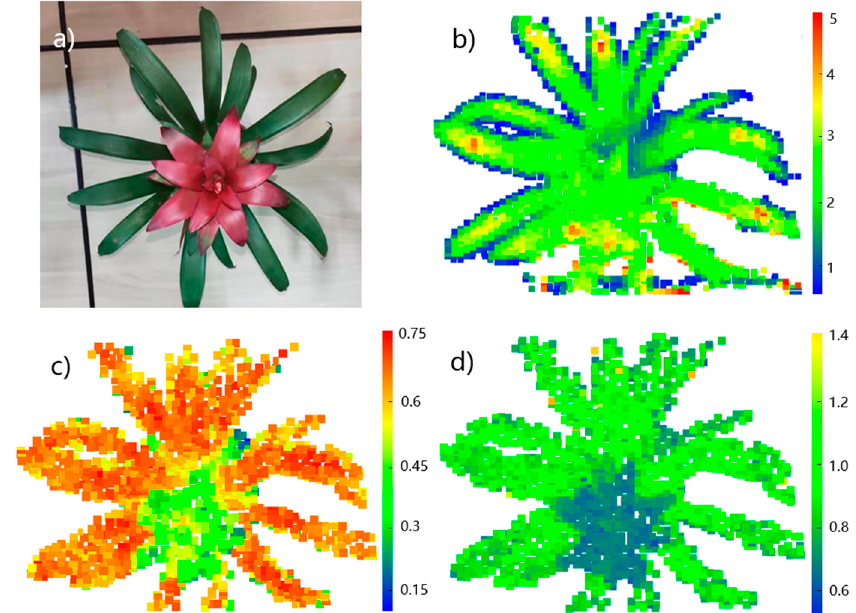
Figure 14. Hyperspectral LiDAR backscatter intensity correction visualization. ( a ) Kniphofia ; ( b ) before correction (near ‐ infrared wavelength intensity ‐ 784 nm); ( c ) after correction (NDLI nr ); ( d ) after correction (SLR ne ).